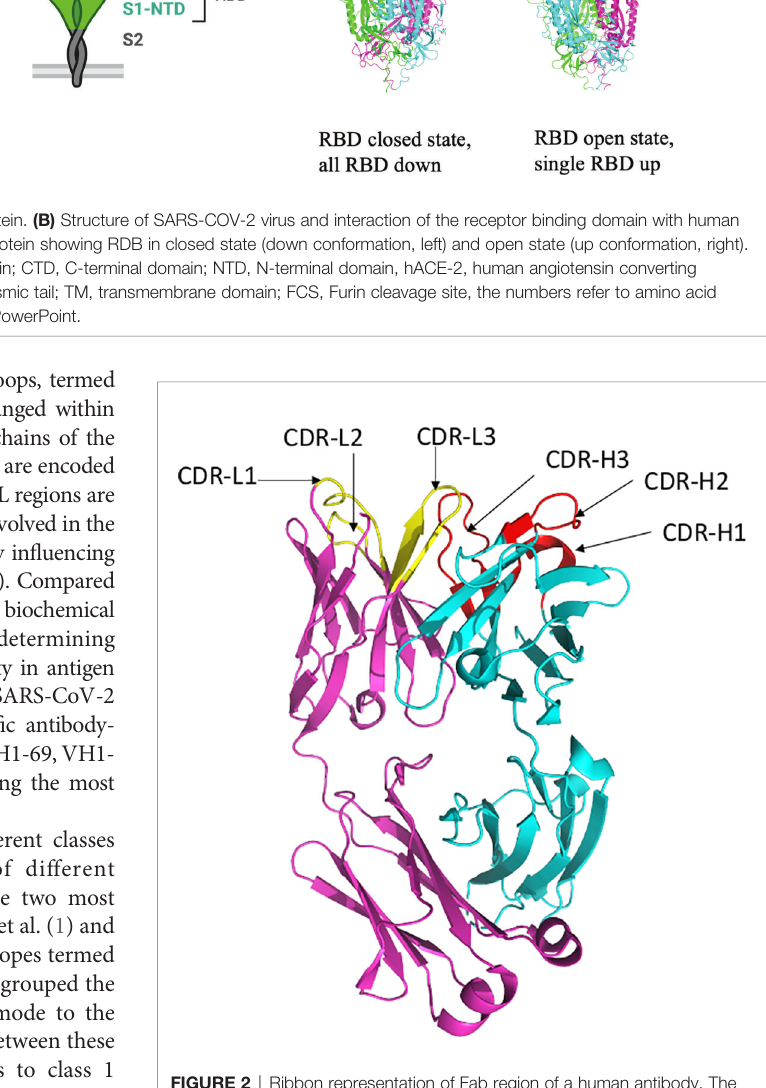
FIGURE 2 | Ribbon representation of Fab region of a human antibody. The heavy chains are shown in cyan, while light chains are shown in pink. Complementarity determining regions (CDR) of heavy chain (CDRH1, CDR- H2, CDR-H3) are shown in red, CDR of light chain (CDR-L1, CDR-L2, CDR- L3) are shown in yellow. Figure drawn by using Pymol; residues obtained from PDB (www.rcsb.com) using following PDB ID 7CR5.